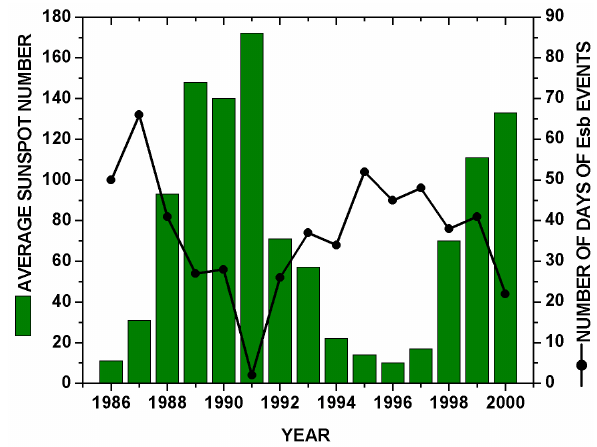
Fig. 3a. Distribution of the percentage occurrence of the E sb events on days with A p < 15, during the solstitial months with the average sunspot numbers corresponding to these days of the months of each year from 1986–2000.